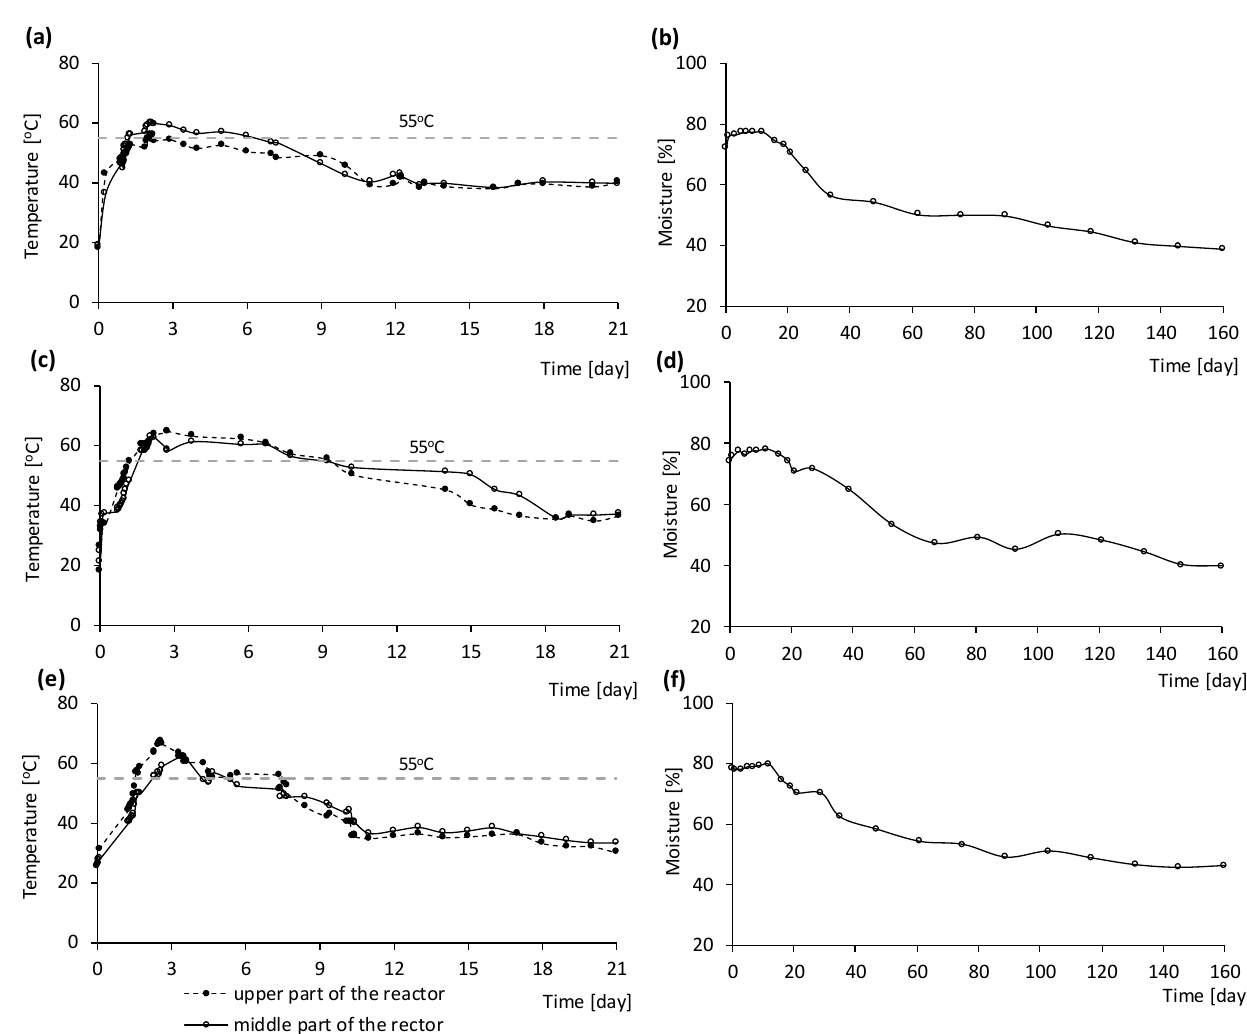
Figure 1. Temperature profiles ( a , c , e ) and changes in the moisture content ( b , d , f ) in the bioreactor during composting (until the 21st day in the bioreactor, and then in the windrow) of FC 1 ( a , b ), FC 2 ( c , d ), and FC 3 ( e , f ).